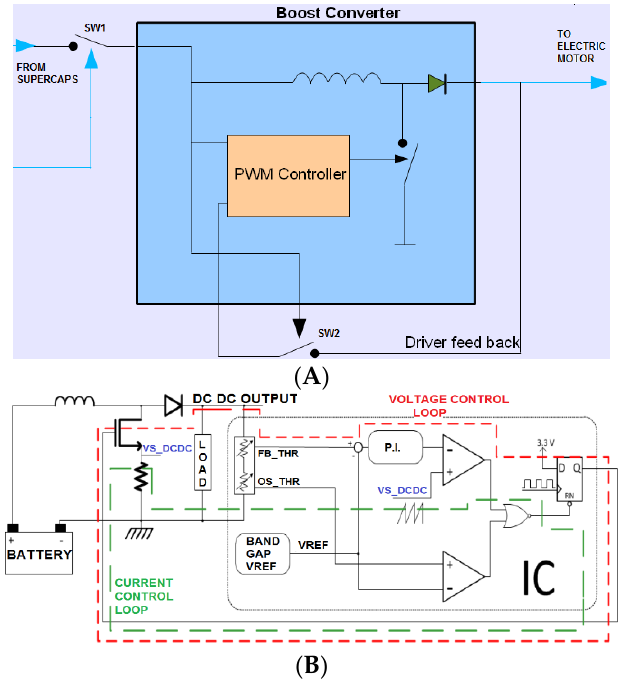
Figure 2. ( A ) Simplified schematic diagram and ( B ) detailed control loops, of the DC DC converter in boost mode, with programmable digital output value.